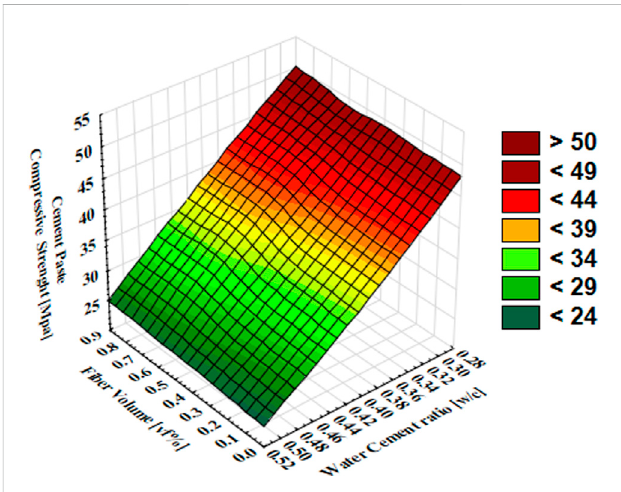
FIGURE 7 Cement-paste compressive strength against fi bre V f and w/c